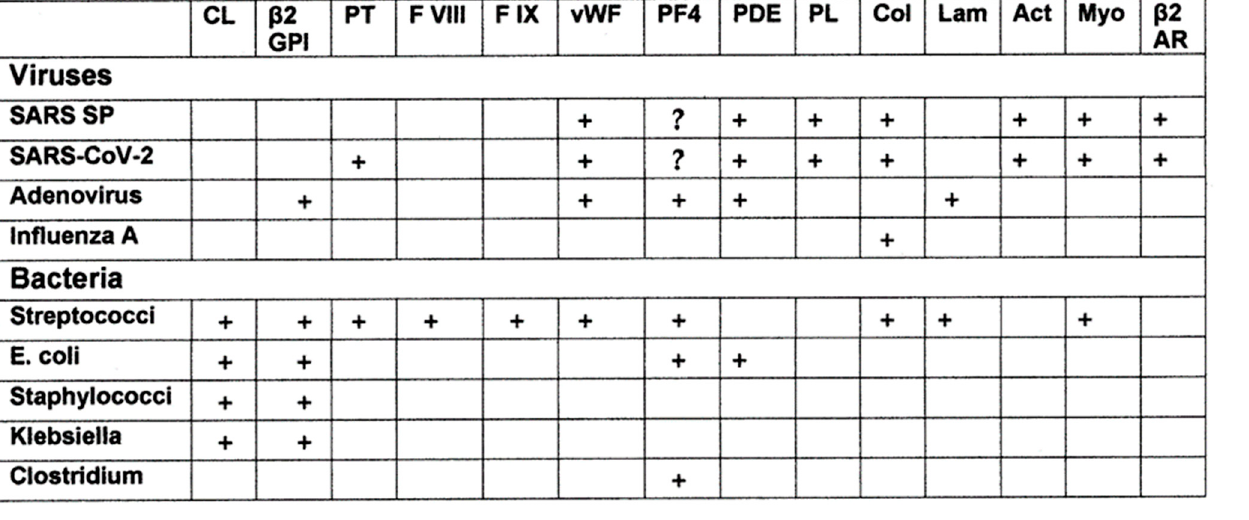
Figure 9. Summary of experimental results of binding to proteins targeted by autoimmune processes in COVID-19 by rabbit polyclonal SARS-CoV-2 antibodies, human anti-SARS-CoV-2 antibod- ies and similar antibodies against other infectious agents associated with COVID-19 summarized from [69,70,103–106]. Plus signs (+) indicated significant binding found between the antibody (left-hand column) and the human protein antigen (top row). Question marks (?) indicate that contradictory findings were reported by different studies, some observing significant binding while others reported no binding. CL = cardiolipin; β 2GPI = beta 2 glycoprotein 1; PT = prothrombin; F VIII = factor VIII; F IX = factor IX; vWF = von Willebrand factor; PF4 = platelet factor 4; PDE = phosphodi- esterase; PL = phospholipid; Col = collagen; Lam = laminin; Act = actin; Myo = myosin; β 2AR = beta 2 adrenergic receptor. SARS SP = SARS-CoV-2 spike